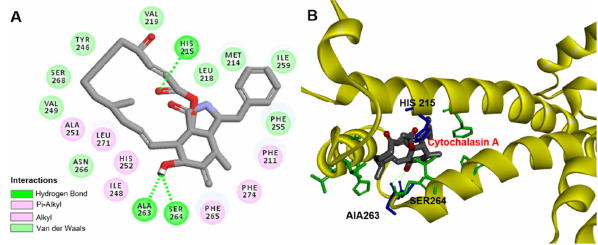
Figure 6. The simulated modeling of cytochalasin A binding to D1 protein of A. adenophora . ( A ) Hydrogen bonding interactions for cytochalasin A binding to D1 protein. ( B ) Stereo view of cytochalasin A binding environment of D1 protein. Here, carbon atoms are shown in grey, nitrogen atoms in blue, oxygen in red and hydrogen atoms in white. The possible hydrogen bonds are indicated by dashed lines.